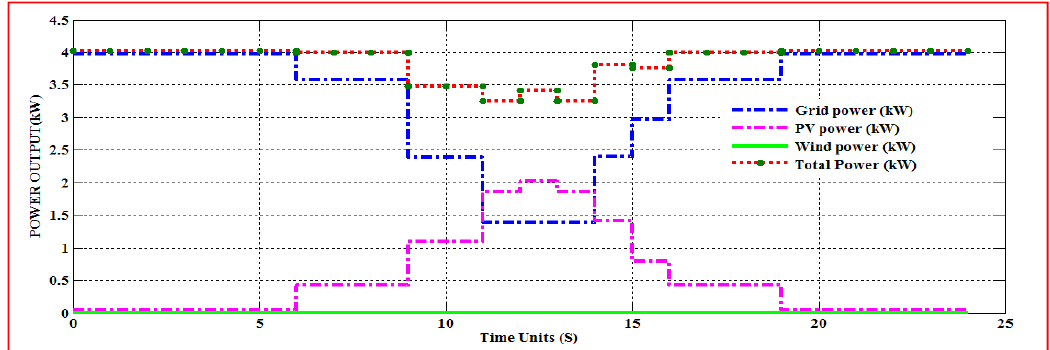
Figure 18. PV with grid energy generation in the absence of wind energy.